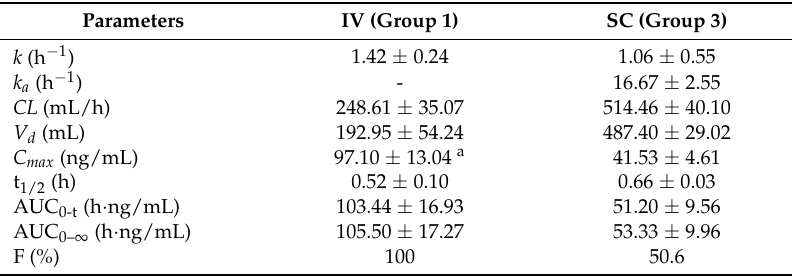
Table 1. PK parameters of leuprolide after IV and SC administration of leuprolide solution (mean ± standard error (SE), n =